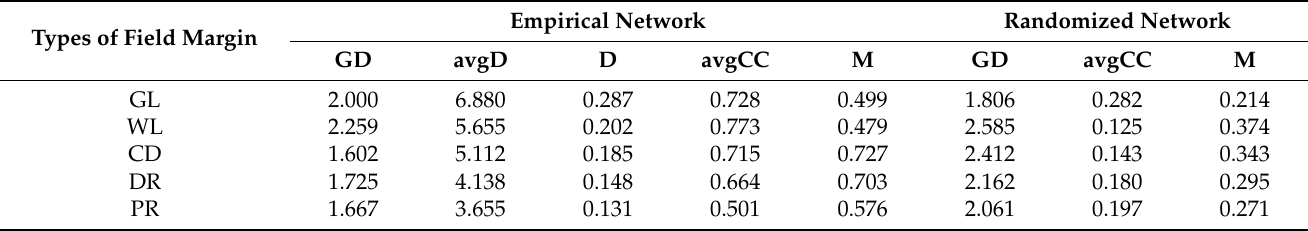
Table 2. Topological parameters of the ecological network of arthropod communities within artificial and semi-natural field margins. GD: average path distance; avgD: average degree; D: Density; avgCC: average clustering coefficient; M: modularity. GL, WL, CD, DR, and PR represent grassland, woodland, irrigation canals and ditches, dirt roads, and paved